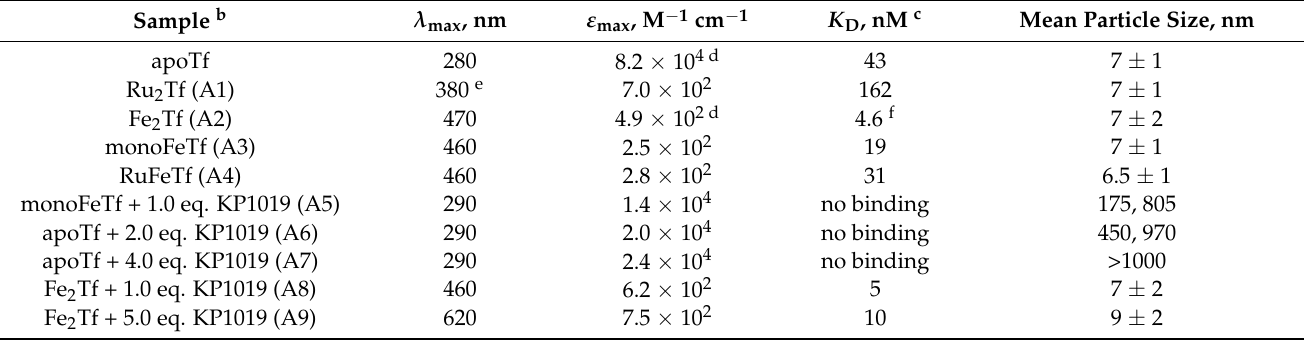
Table 2. Summary of UV-Vis, BLI and mean particle size data for Fe(III)–Tf and Ru(III)–Tf adducts a